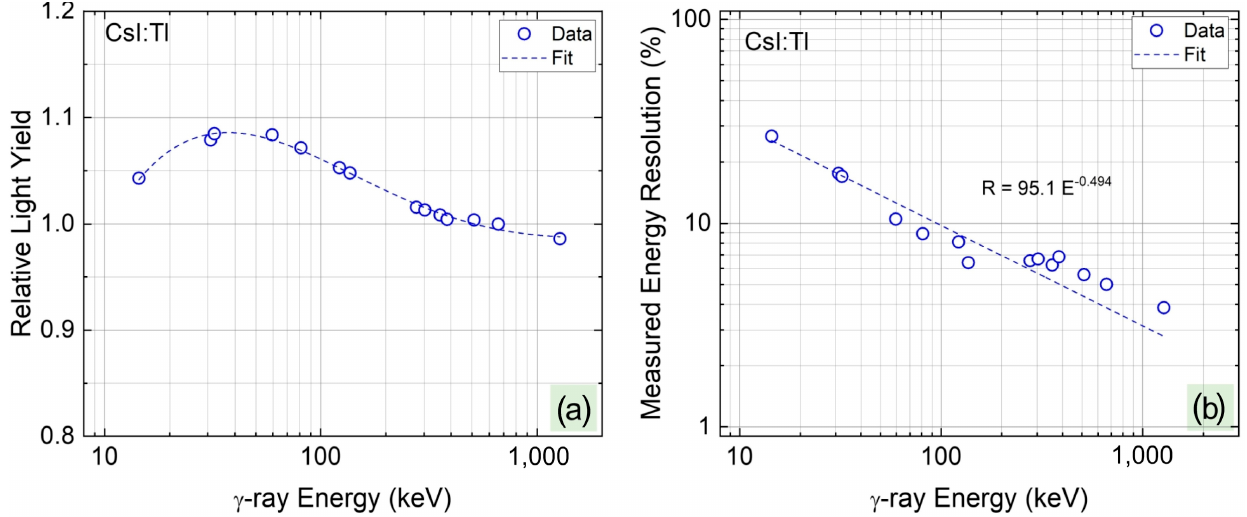
Figure 4. ( a ) Nonproportionality data and ( b ) measured energy resolution data for CsI:Tl crystals grown by XI, Inc.